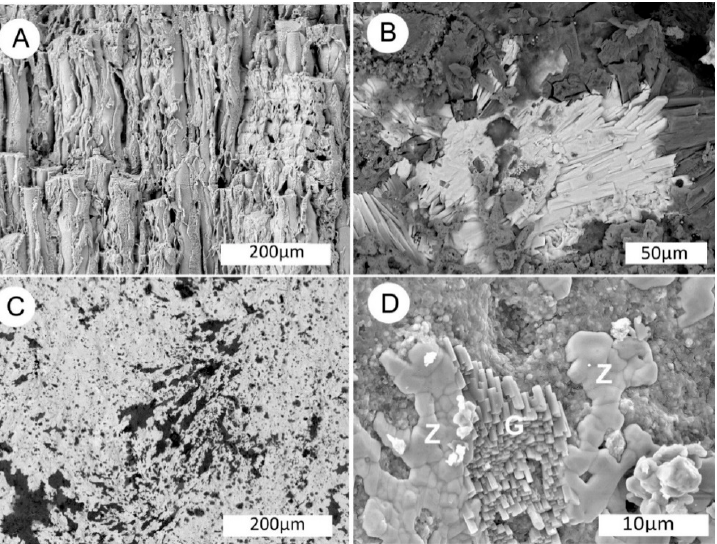
Figure 11. SEM images of uraniferous wood from White Canyon District (UT). ( A ) Silicified wood, oblique longitudinal view showing unmineralized spaces between some adjacent cells. ( B ) BSE image showing prismatic crystals of zippeite on wood surface. ( C ) Layer of zippeite encrusting specimen surface, BSE image. ( D ). High magnification SE image showing semi-botryoidal zippeite ( Z ) adjacent to gypsum crystal cluster ( G ).